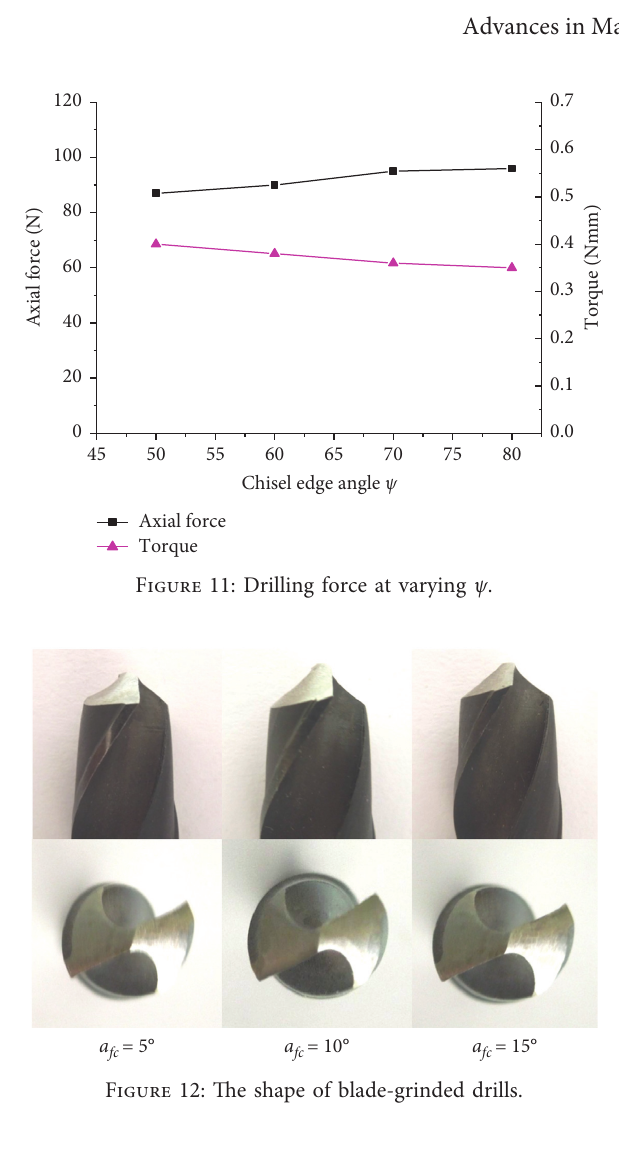
� 5 ° . (b) a � 10 ° . (c) a � 15 ° fc fc fc